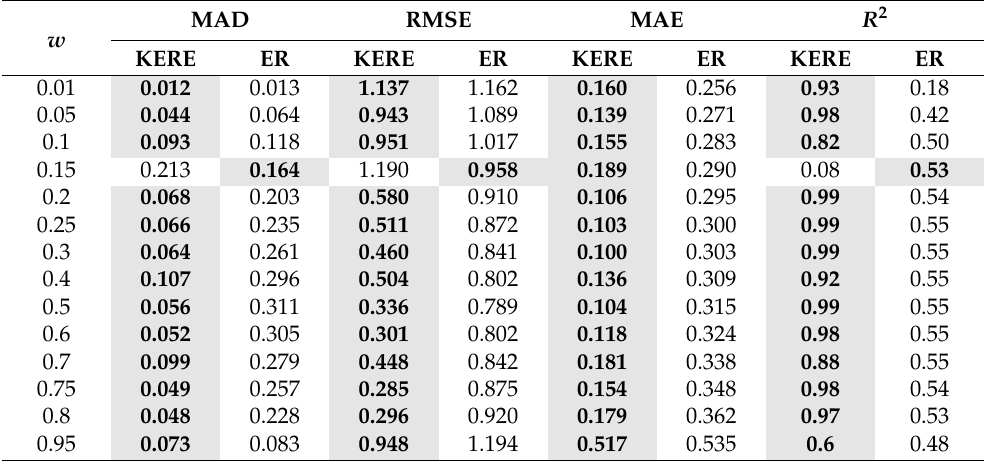
Table 6. Indirect emissions. The training MAD, RMSE, and MAE metrics for both KERE and ER are reported with respect to the various expectile levels ranging between 0.01 and 0.99.